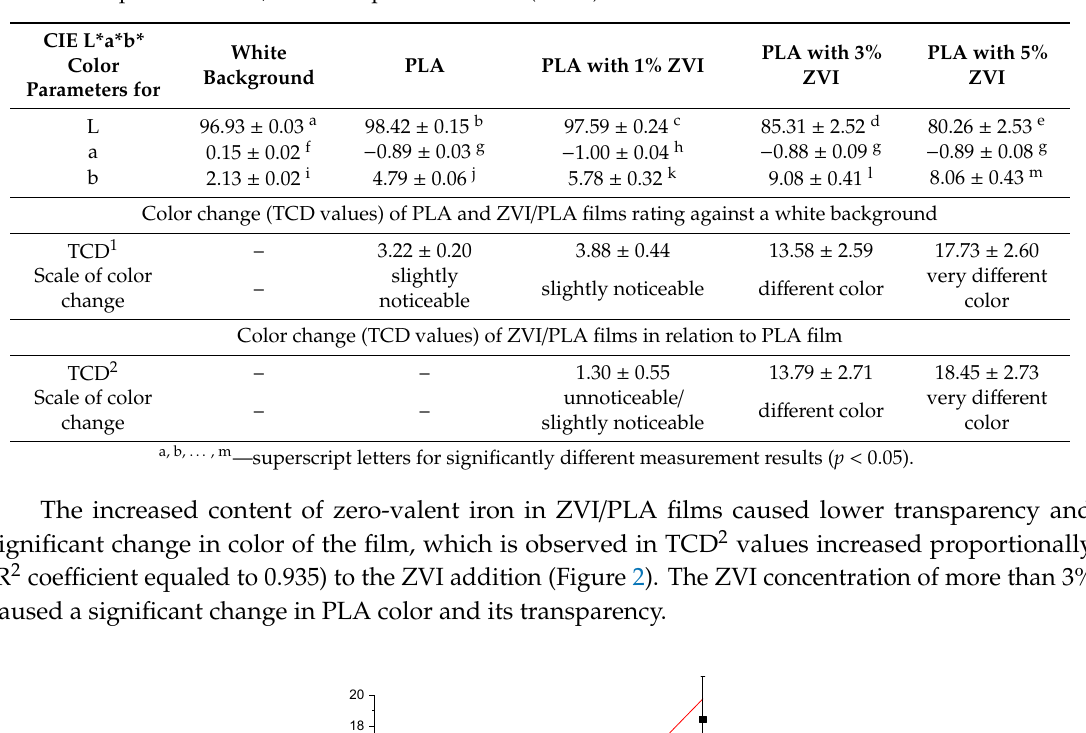
Table 2. Color parameters (in CIE L*a*b* system) obtained for white background, pure PLA films and PLA with the different addition of ZVI, followed by total color difference index values calculated for the color comparison of PLA and ZVI/PLA films with the color of white background (TCD 1 ) and for the comparison of ZVI/PLA with pure PLA films (TCD 2 )